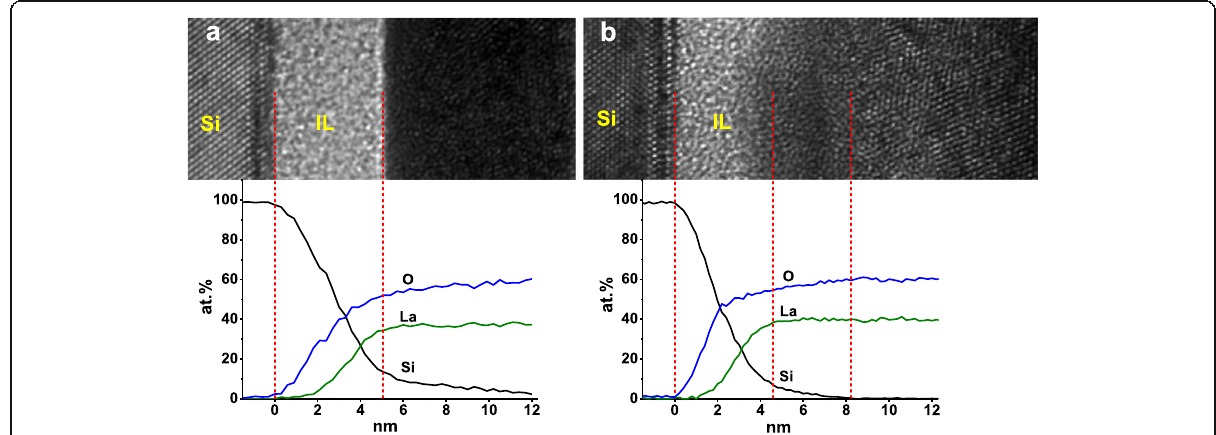
Fig. 2 HRTEM images and EDX profiles near the interface for La 2 O 3 films annealed at 600 °C. a 10 and b 20 nm La 2 O 3